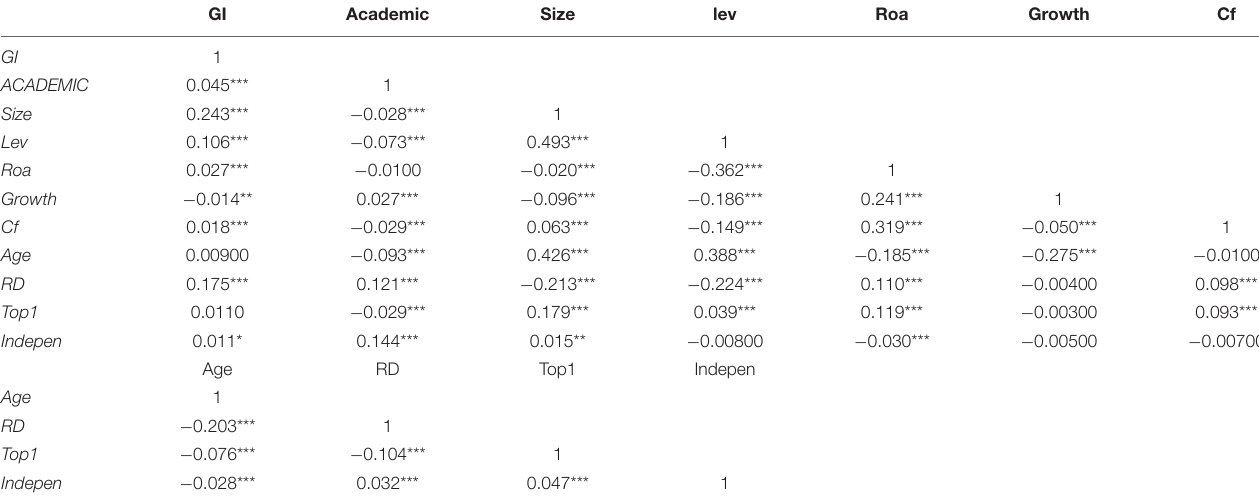
TABLE 3 | Correlation